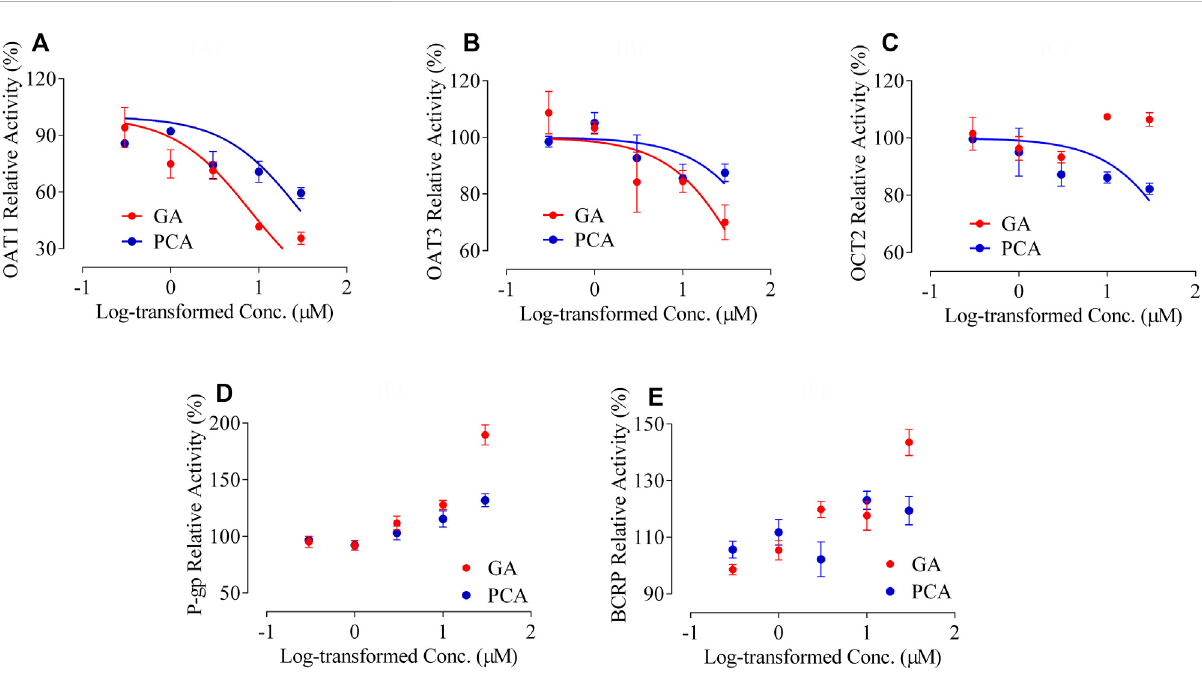
FIGURE 9 Inhibitory effects of GA and PCA on the activity of multiple transporters, including human organic anion transporter 1 [hOAT1, (A) ], [hOAT3 (B) ], human organic cation transporter 2 [hOCT2, (C) ], human multidrug resistance protein 1 [hMDR1, (D) ], and human breast cancer resistance protein [hBCRP, (E) ] (mean ± SD, n =